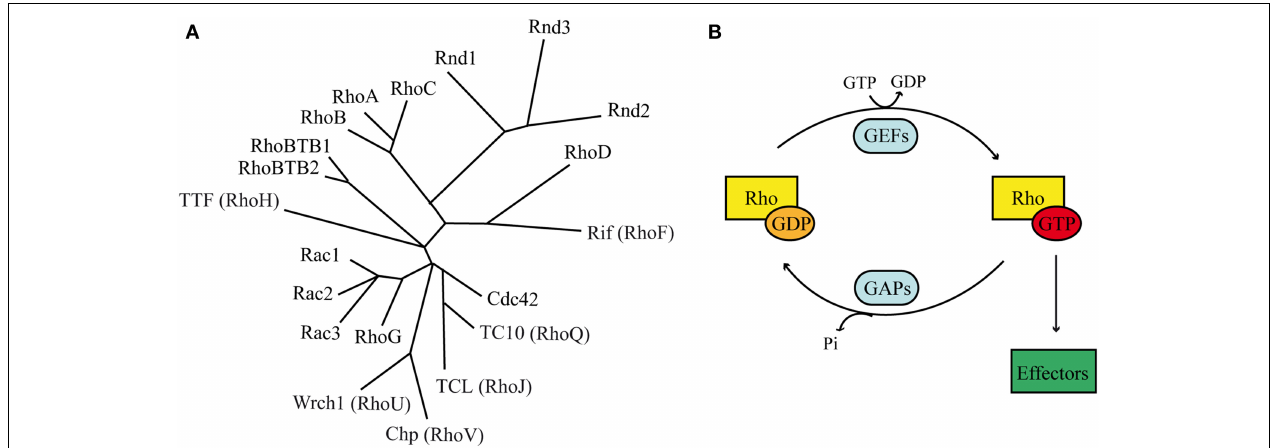
FIGURE 2 | Rho GTPases. (A) Phylogenetic tree based on alignment of the aminoacid sequences of the 20 Rho GTPases. Rnd proteins form a distinct branch, which is closely related to Rho members. (B) Classical Rho GTPases cycle between an inactive GDP-bound state and an active